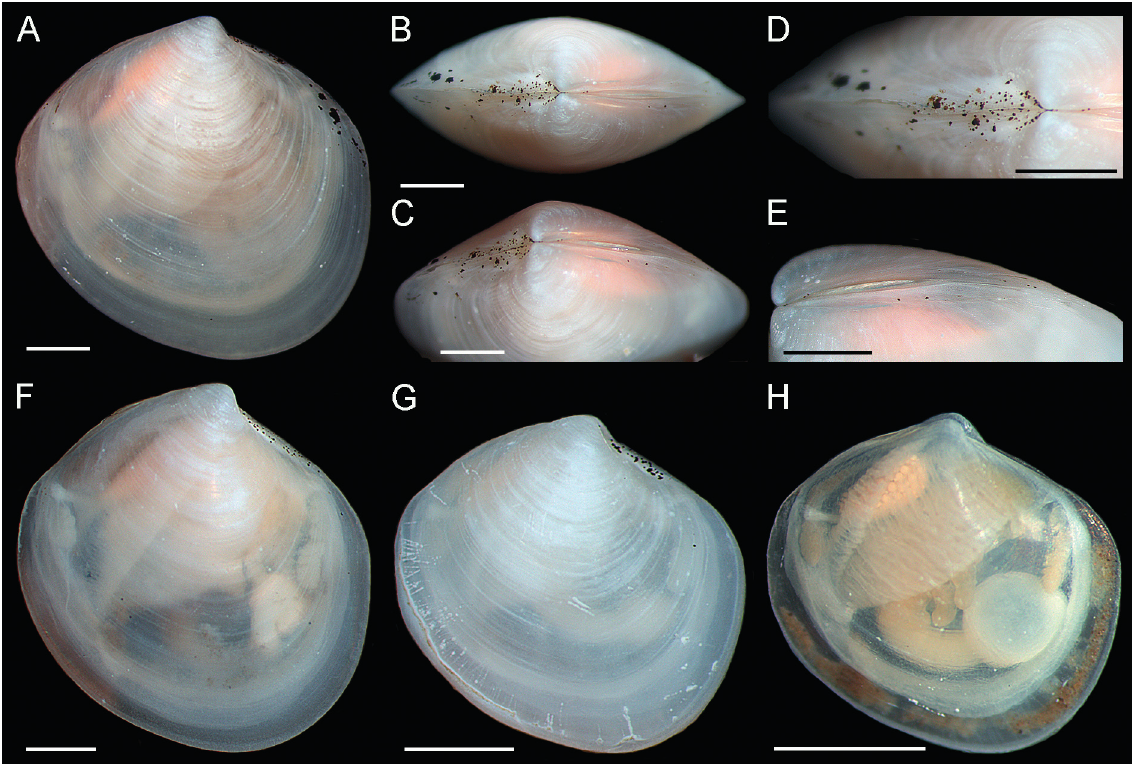
Fig. 13. Thyasira kharkovensis sp. nov. A–E . Paratype (MIMB 43825), exterior of right valve and dorsal views of both valves, shell length 5.5 mm. D . Lunule. E . Escutcheon with auricle. F . Paratype (MIMB 43825), shell length 5.2 mm. G–H . Variability of shell shape. G . Shell length 3.3 mm (MIMB 43835). H . Shell length 2.3 mm (MIMB 43832). Scale bars = 1